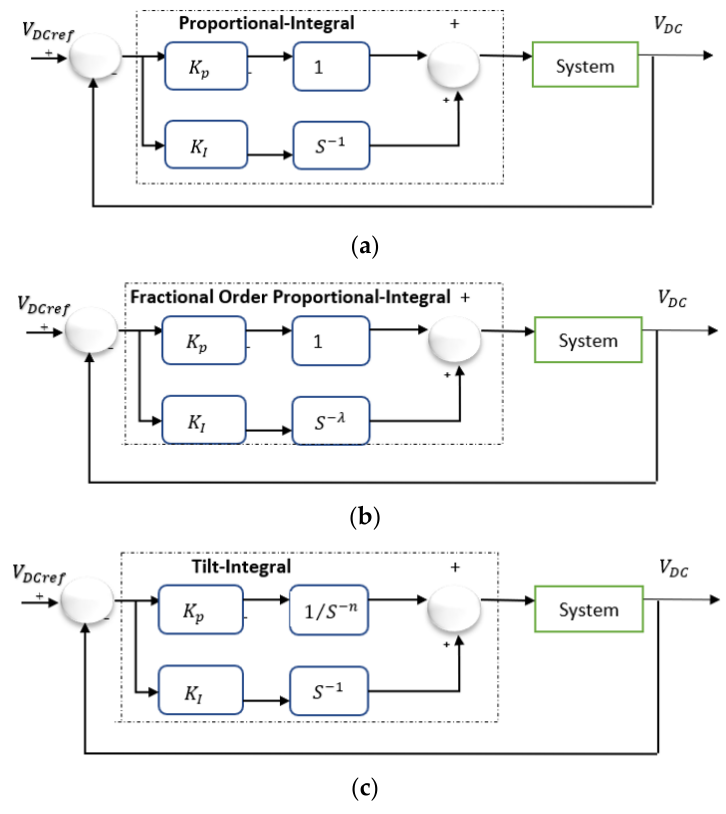
Figure 3. Block diagram of the ( a ) PI controller, ( b ) FOPI controller, and ( c ) TI controller.